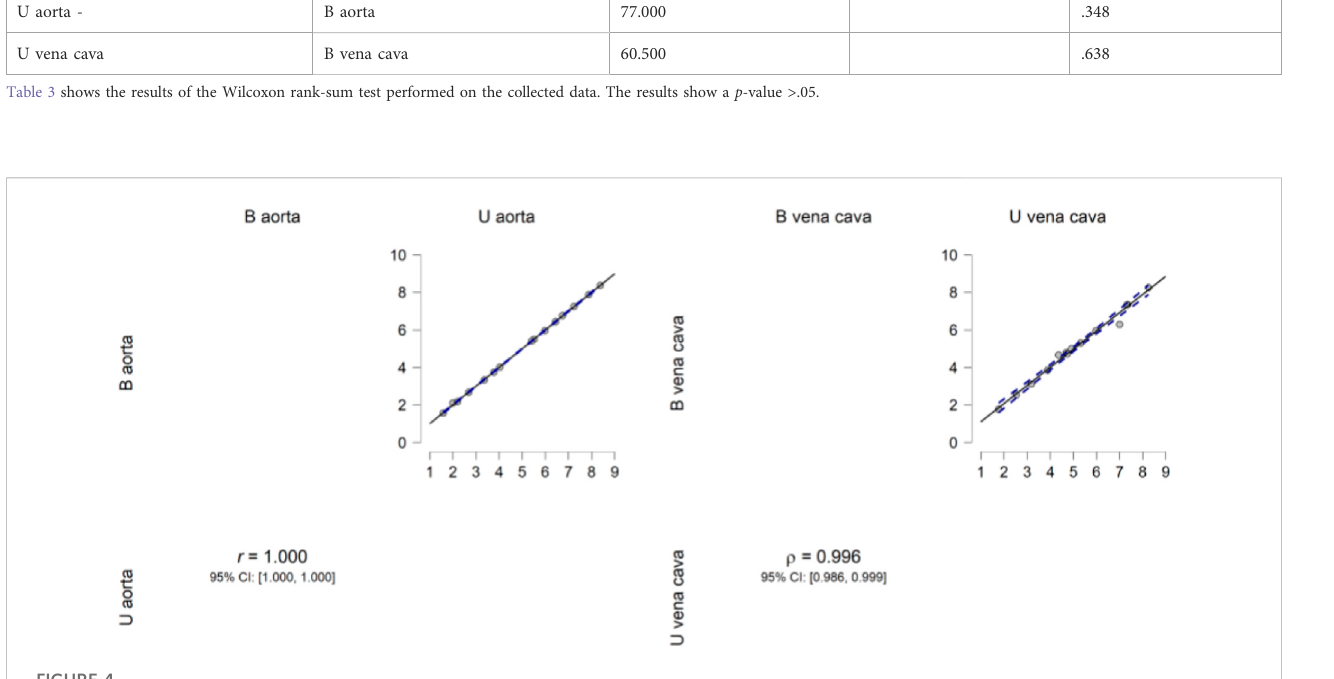
FIGURE 4 Pearsons ’ s correlation plot. Pearson ’ s correlation plot between the aorta and vena cava measurements from the two software programs. The data show high